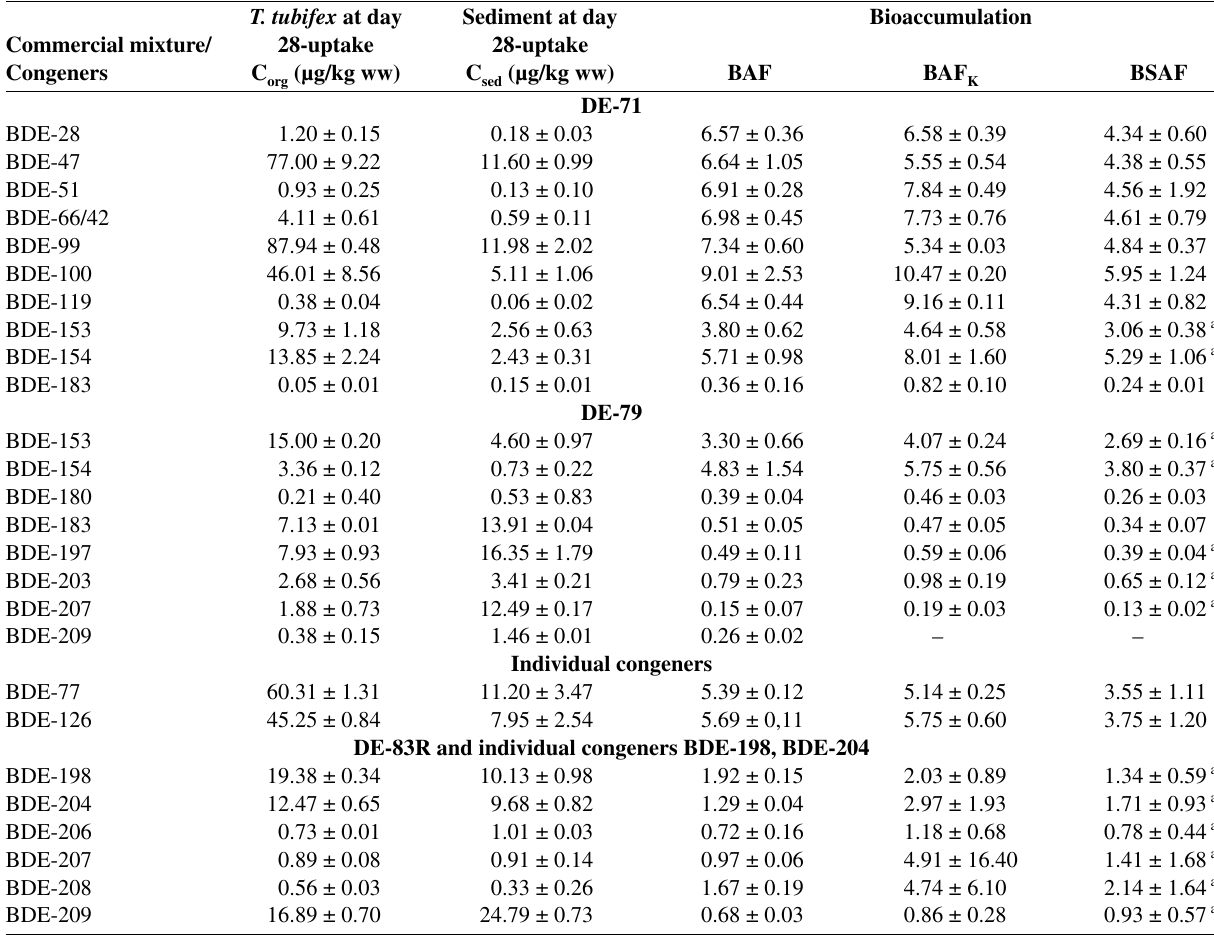
Table 3. The concentration of the BDE in T. tubifex and in the spiked sediment on day 28 and the bioaccumulation factor BAF, kinetic bioaccumu- and sediment-biota normalized accumulation factor (BSAF) presented with a standard lation factor BAF K